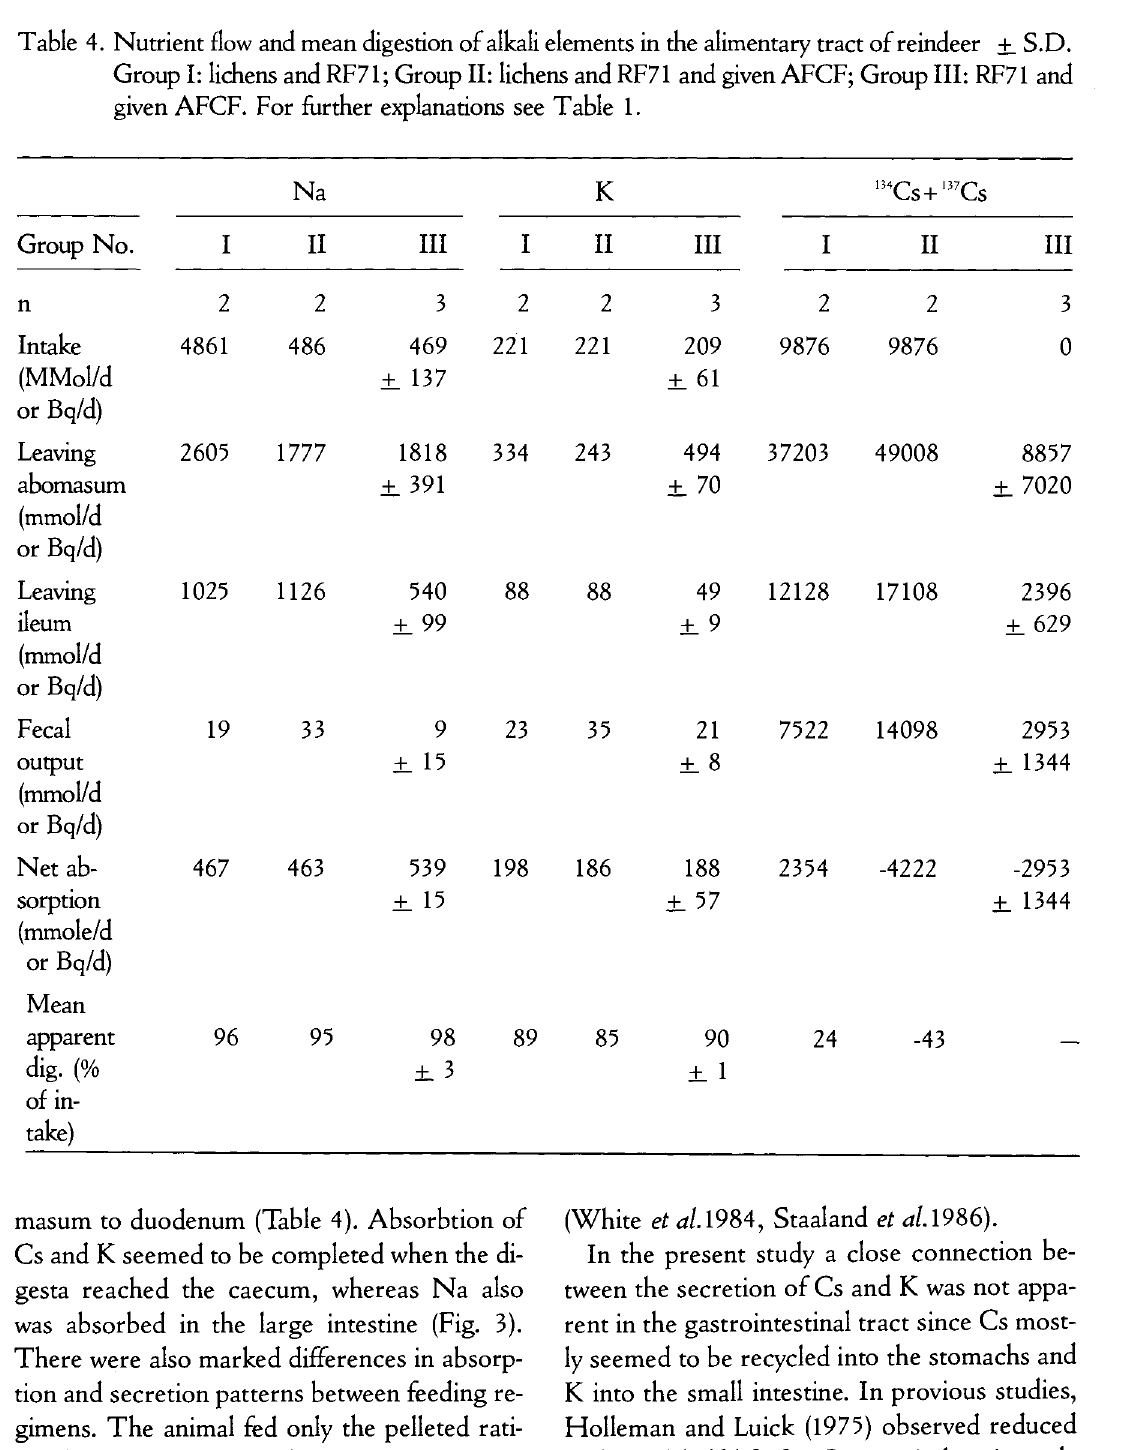
Table 4. Nutrient flow and mean digestion of alkali elements in the alimentary tract of reindeer +_ S.D. Group I: lichens and RF71; Group II: lichens and RF71 and given AFCF; Group III: RF71 and given AFCF. For further explanations see Table 1.